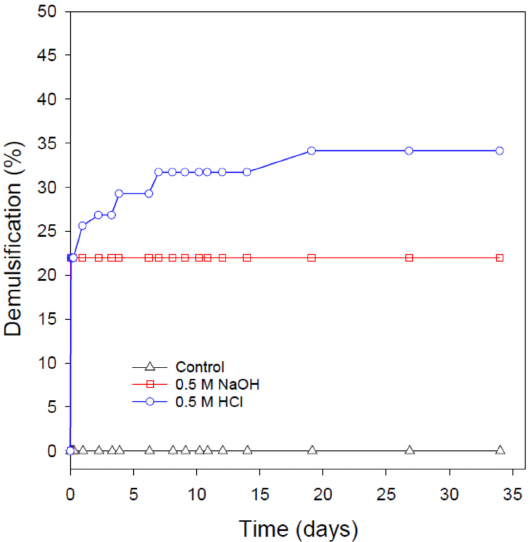
Figure 7. The long-term stability and demulsification process of the crude O/W nanoemulsion sta- bilized by 0.5 wt% SDBS using the pH-switching mechanism through the addition of 0.5 M HCl or NaOH. The demulsification process was conducted at ambient conditions and in the absence of any physical disturbances. The first 6 days of the demulsification process is shown in the inset.